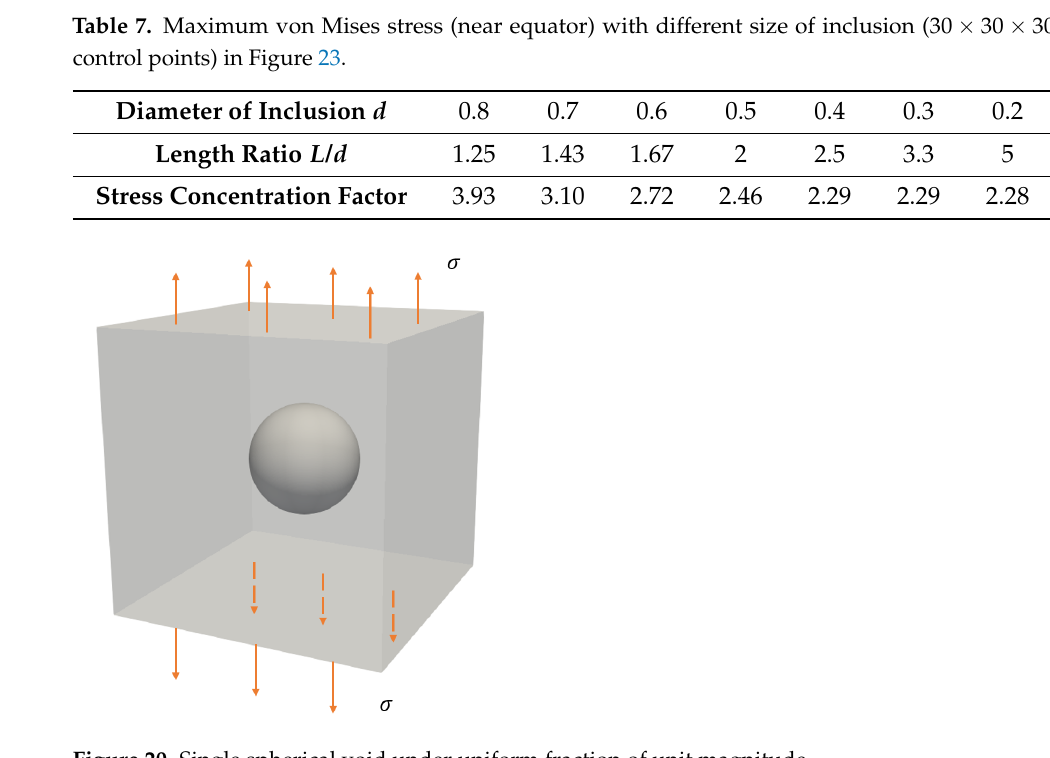
Figure 20. Single spherical void under uniform fraction of unit